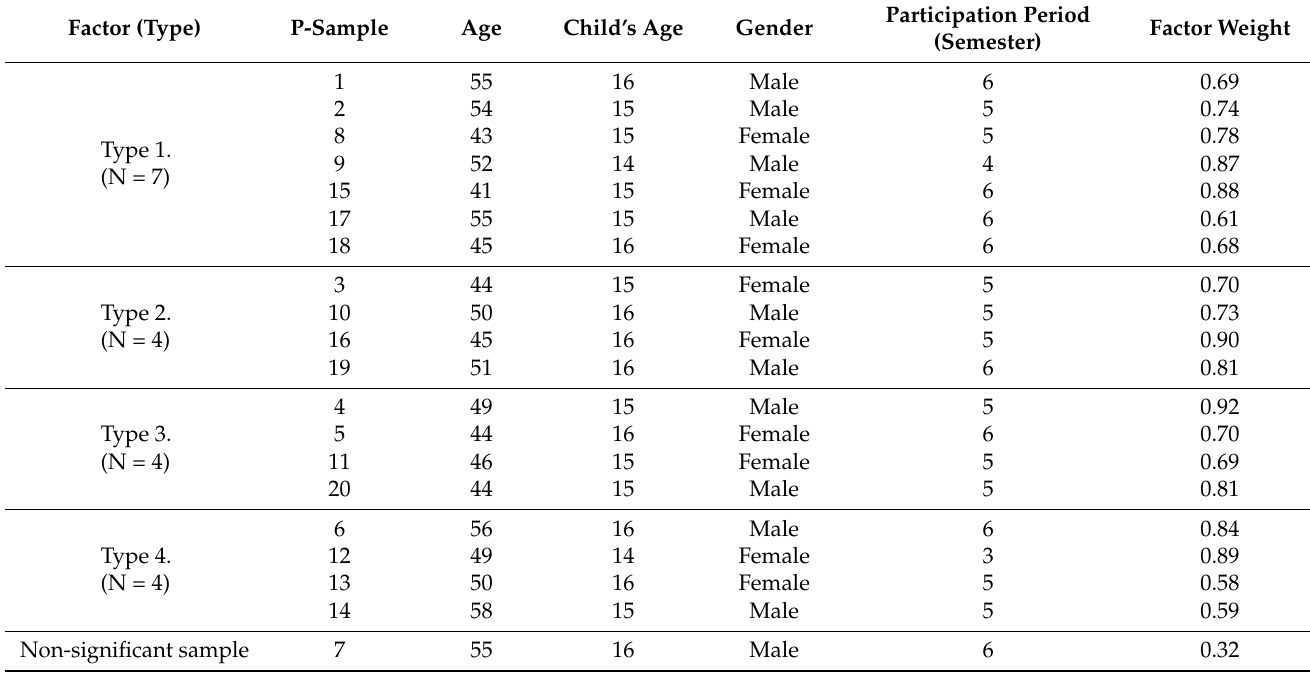
Table 2. Summary of characteristics for P-Sample and factor